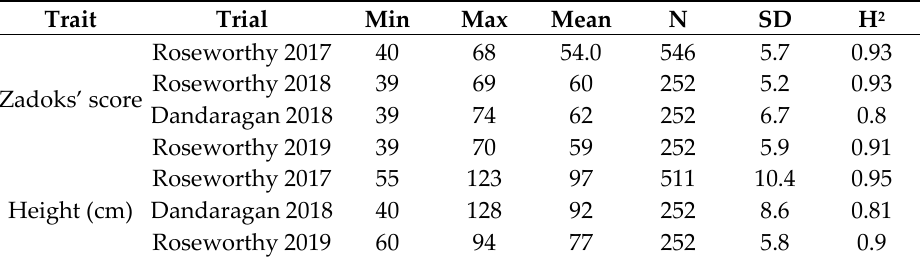
Table 1. Descriptive statistics and heritability estimates of the NAM subset evaluated in each of the four field trial